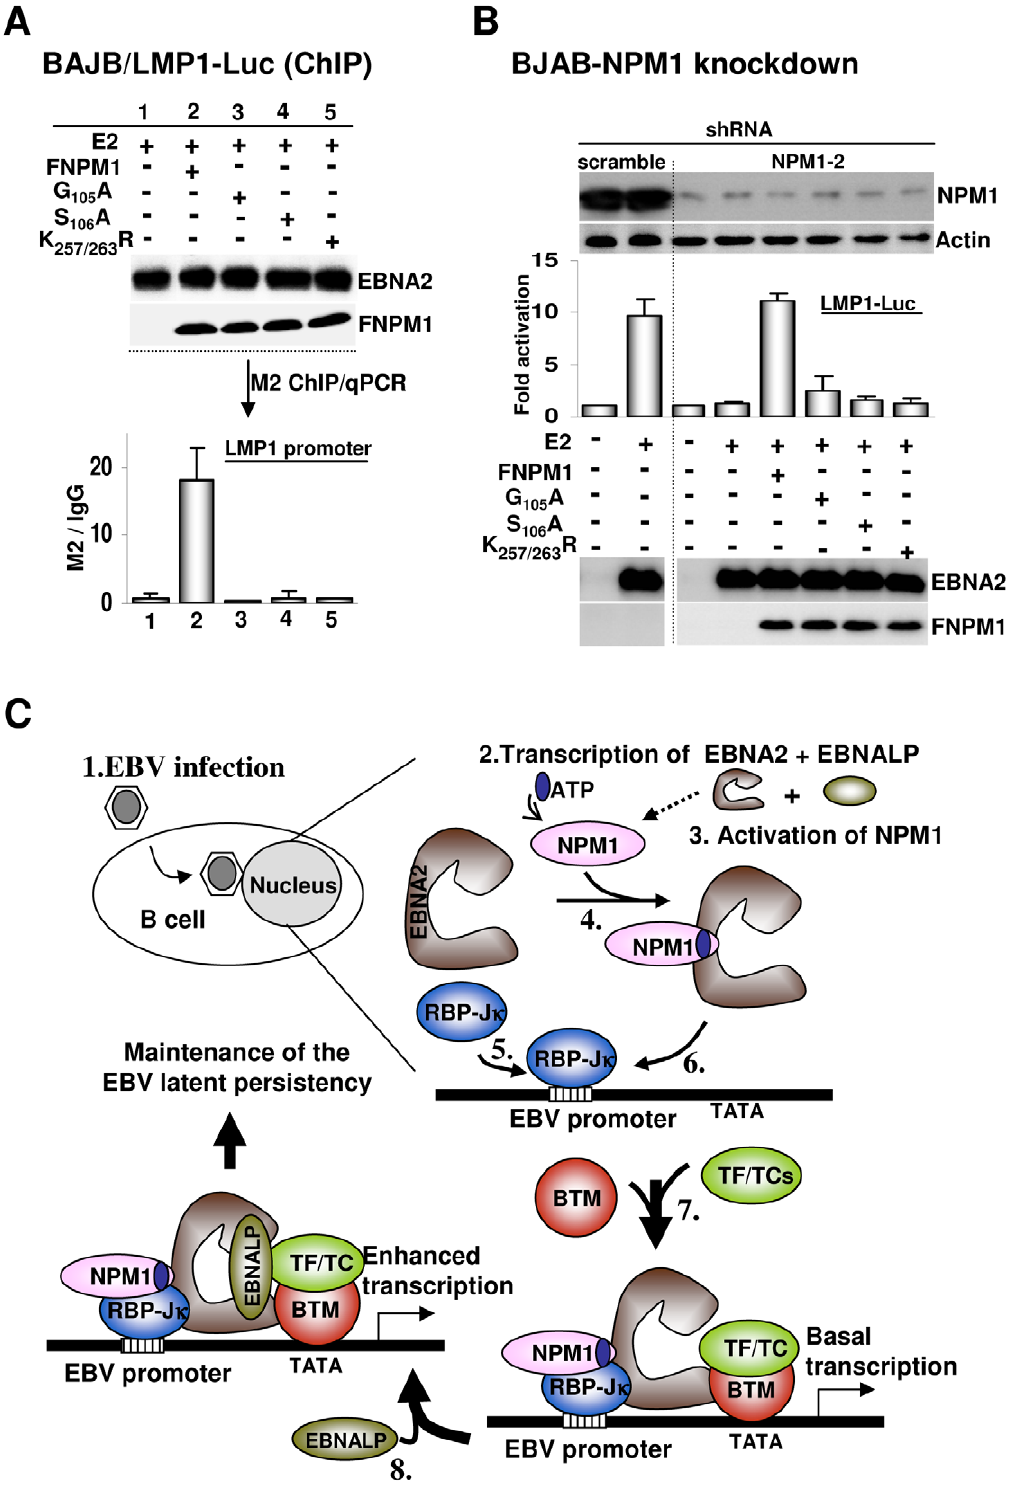
Figure 7. NPM1 binds to EBNA2 and recruits it to the EBV latency-specific LMP1 promoter. A). BJAB-LMP1-Luc cells co-transfected with the plasmids of EBNA2 and FNPM1 or EBNA2 binding mutants were subjected to ChIP assay using M2 antibody or control IgG. The immunoblots for the transfected EBNA2 or FNPM1s are shown. Promoter occupancy of FNPM1 or other mutants was quantified by qPCR. In each case, the data from M2 ChIP were normalized to the background level that was identified for IgG ChIP. B). The transfected FNPM1 and each FNPM1 mutant were used to rescue the defect in EBNA2-dependent transcription of NPM1 knockdown cells. The intrinsic EBNA2-inducing LMP1-Luc activity observed in BJAB- scrambled cells was used as a positive control. The expression levels of the transfected plasmids, endogenous NPM1, and actin control for each assay are shown. C). A new version of the working model proposed for EBNA2-dependent transcription in EBV immortalized B lymphocytes. doi:10.1371/journal.ppat.1003084.g007 PLOS Pathogens |